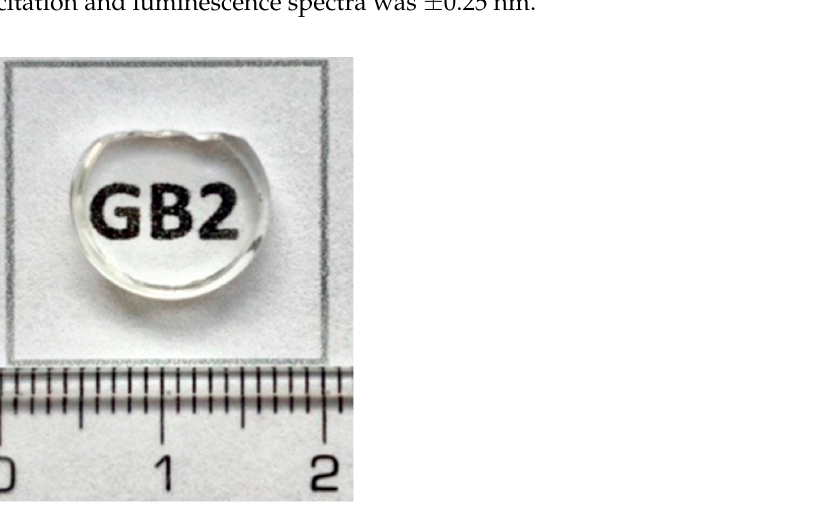
Figure 2. Photographs of the obtained glass sample: 30GeO 2 -30B 2 O 3 -30BaO-10Ga 2 O 3 (GB2). Table 1. Nominal composition (mol%) and GeO 2 /TiO 2 ratio of glass samples.